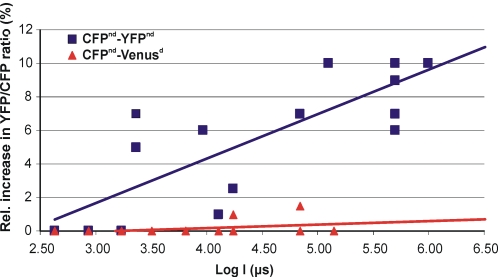
UV-induced photochromism.Change in ratio of YFP to CFP emission in CFPnd-linker-YFPnd (squares) and CFPnd-linker-Venusd (triangles) following exposure to UV light for the indicated times. CFPnd-linker-YFPnd as well as free YFP (data not shown) display a dose-dependent increase in emission that maximizes at about 10%, whereas Venus and cp173Venus (not shown) are insensitive to UV exposure. See Methods for further detail.